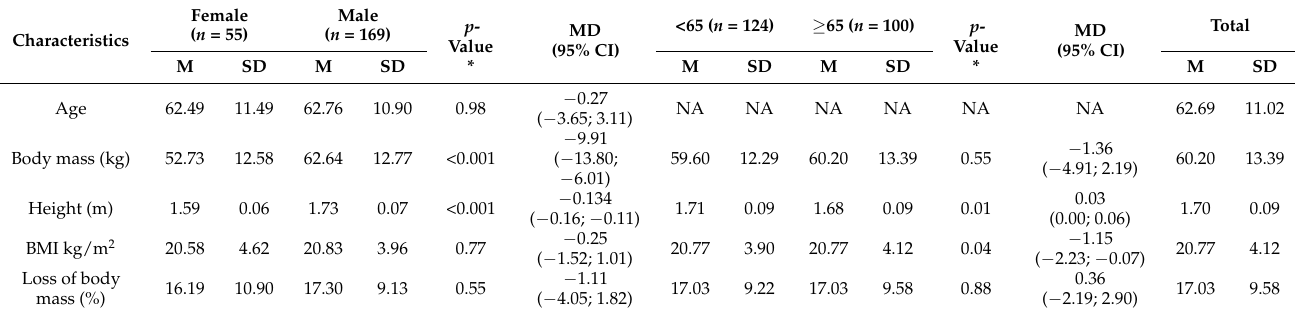
Table 2. Group characteristics of the study group divided by sex and age.